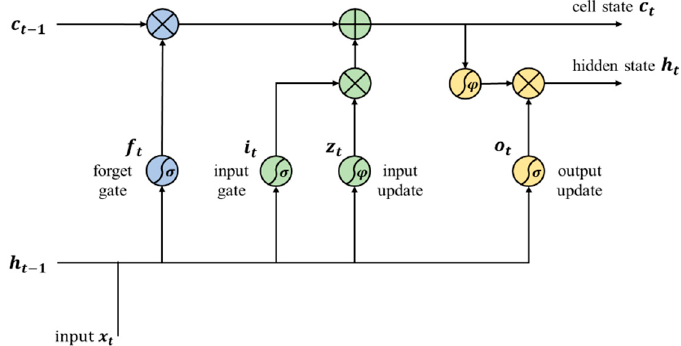
Figure 2. Structure of long short-term memory (LSTM) [26].